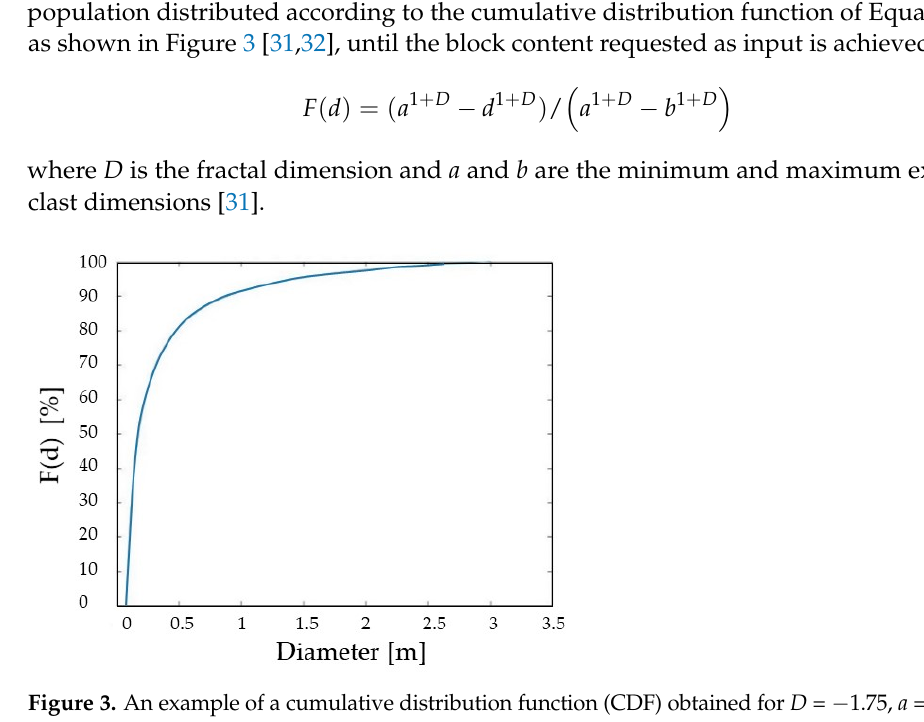
Figure 2. An example of a tunnel partially located outside the rectangular control area to simulate different geologic units being present in a tunnel section.